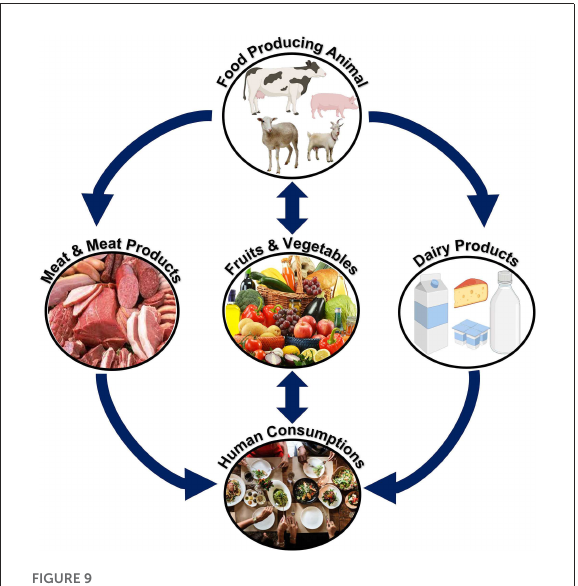
FIGURE9 Transmission of Y. enterocolitica in humans. Y. enterocolitica can be transmitted to humans from animals through the consumption of contaminated food/meat or meat/dairy